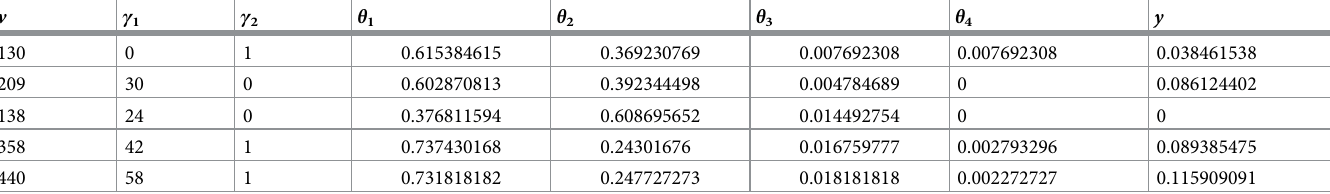
Table 4. Samples of the feature